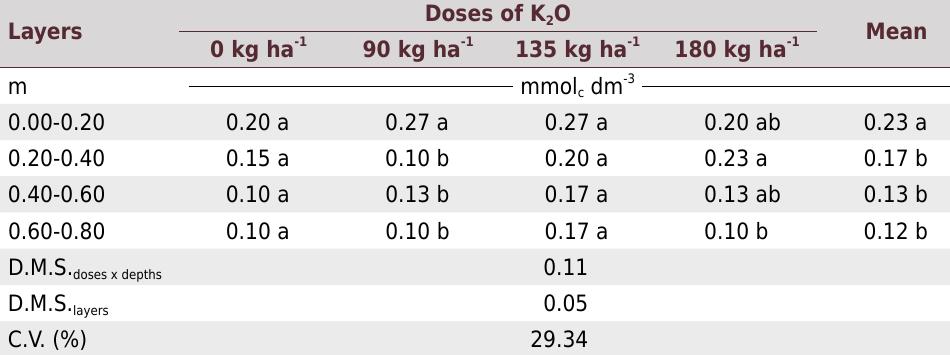
Table 2. Potassium levels in the soil in the interline of E. urophylla hybrid at depths of 0.00-0.20, 0.20-0.40, 0.40-0.60, and 0.60-0.80 m, evaluated at 66 months after planting, as a function of doses of K 2 O